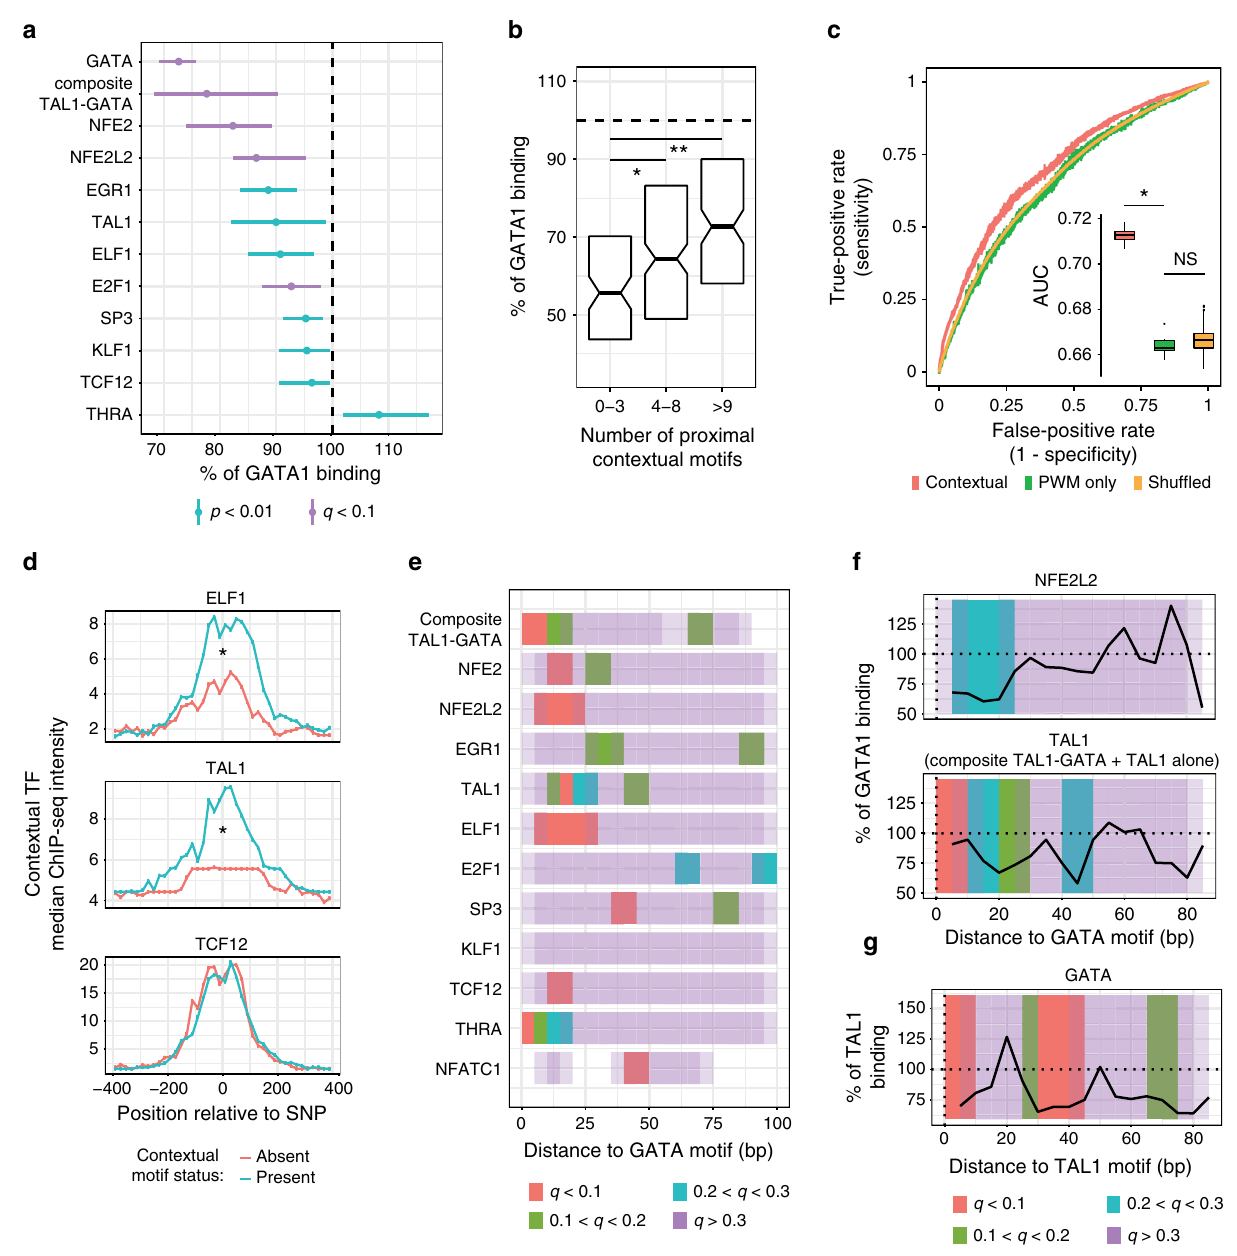
Fig. 4 Genetic variation in nearby contextual sequences regulates GATA1 binding. a TFs whose motifs signi fi cantly alter GATA1 binding (% impact, median ± 95% CI) when disrupted by a discSNP. Vertical line indicates no effect, color indicates signi fi cance level. b DiscSNPs that directly disrupt a GATA motif have variable impacts on GATA1 binding depending on the number of positive co-regulatory motifs (from a ) found within 100 bp of the discSNP. Wilcoxon's * p = 0.02, ** p < 0.0004. Boxplot center is median, hinges are 25 and 75% percentiles. c Receiver operating characteristic curve (ROC) curves comparing logistic regression models that predict GATA1 binding based on either the GATA1 motif alone (PWM only), a combination of the GATA1 motif and nearby contextual regulatory motifs (contextual), or a control combination of the GATA1 motif and scrambled versions of the contextual motifs (shuf fl ed). ROC curves are shown as median of 10 cross-validation runs. Area under the curve (AUC) is represented in the sub-panel as a boxplot of the 10 cross-validation runs, DeLong ’ s paired test for two correlated ROC curves: * p = 9e − 13. Boxplot center is median, hinges are 25 and 75% percentiles, whisker is no > 1.5*IQR. d Median ChIP-seq intensity of three TFs at their corresponding motifs in either an intact state or disrupted by a discSNP within a GATA1 peak. Position is shown relative to the discSNP position (400 bp upstream to 400 bp downstream). Signi fi cant differential binding (*) was